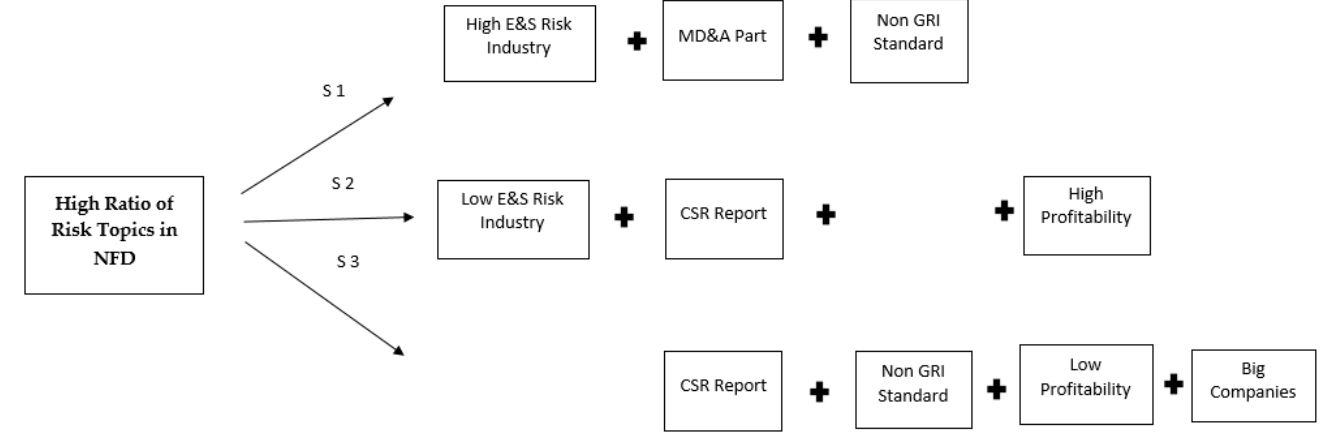
Figure 3. Diagram of QCA results for high ratio of risk topics model. Source: own work with fs/software. Blank space means that a variable is not relevant for a solution. S1 represents Solution 1; S2, Solution 2; and S3, Solution 3, respectively. Solution 1: raw coverage 0.09, unique coverage 0.09, consistency 0.67; Solution 2: raw coverage 0.38, unique coverage 0.19, consistency 0.81; Solution 3: raw coverage 0.21, unique coverage 0.03, consistency 0.79. Model coverage 0.50. Model consistency 0.76.